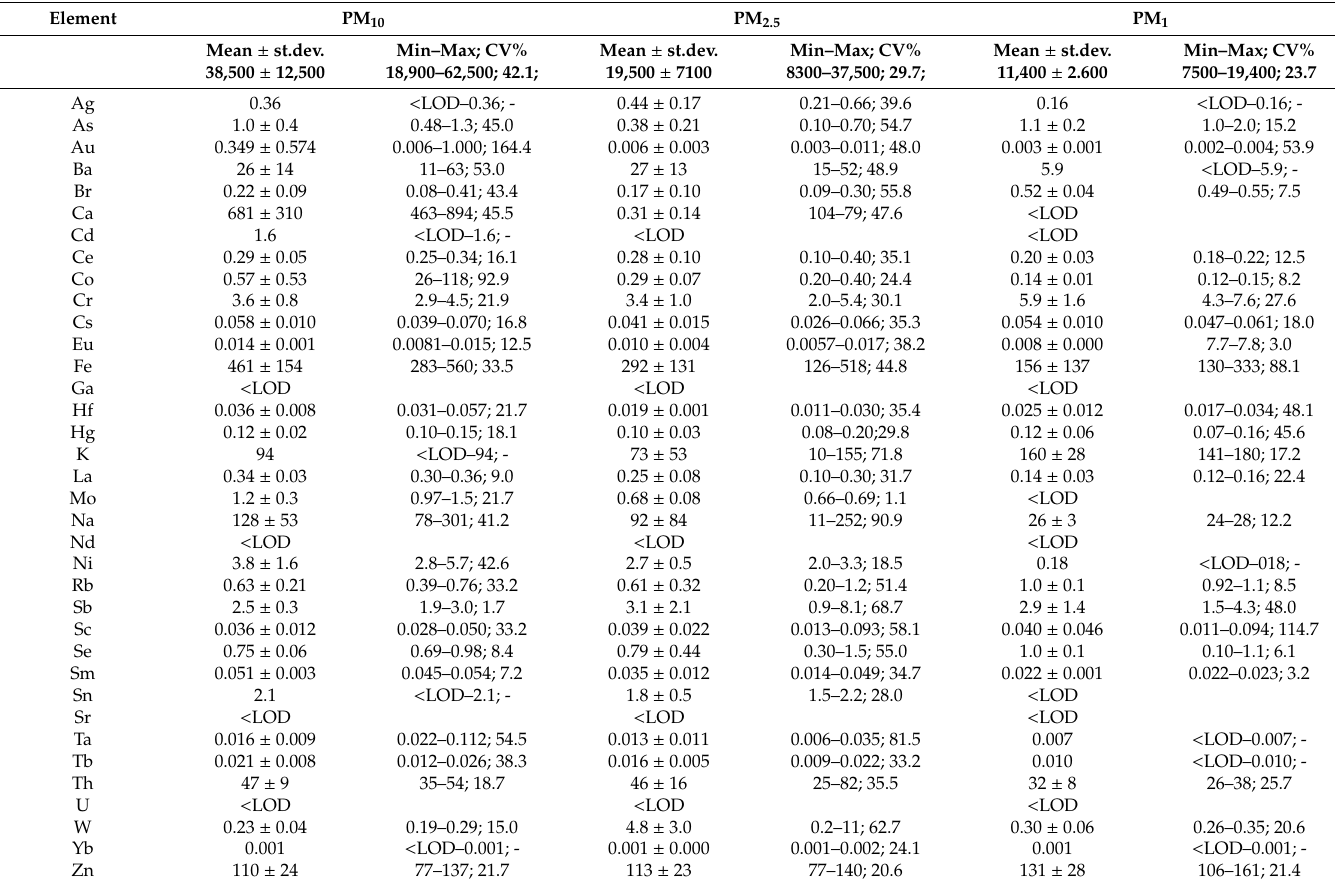
Table 3. Element mean concentration (ng m − 3 ; LOD limit of detection) in the PM 10 , PM 2.5 , and PM 1 samples investigated in this study, along with min / max values and coe ffi cient of variation